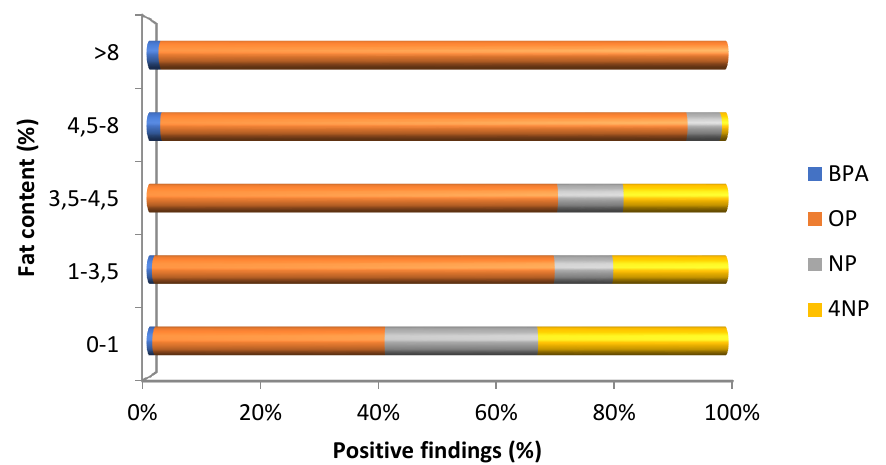
Figure 5. Illustration of the percent (%) occurrence of the detected EDCs in relation to the percent (%) fat content of the analyzed food commodities.